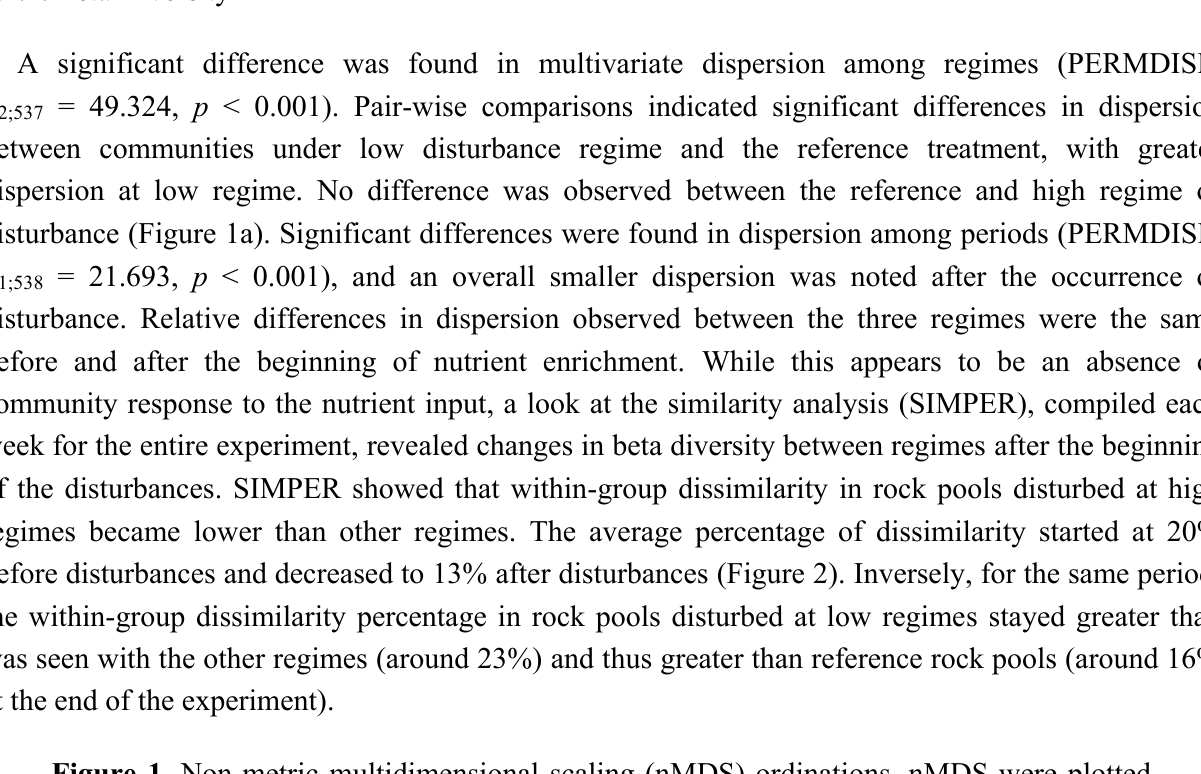
Figure 1. Non-metric multidimensional scaling (nMDS) ordinations. nMDS were plotted for each regime before and after the beginning of disturbances by ( a ) nutrient enrichment and ( b ) draining. High = black triangle; Low = red square; Reference = green